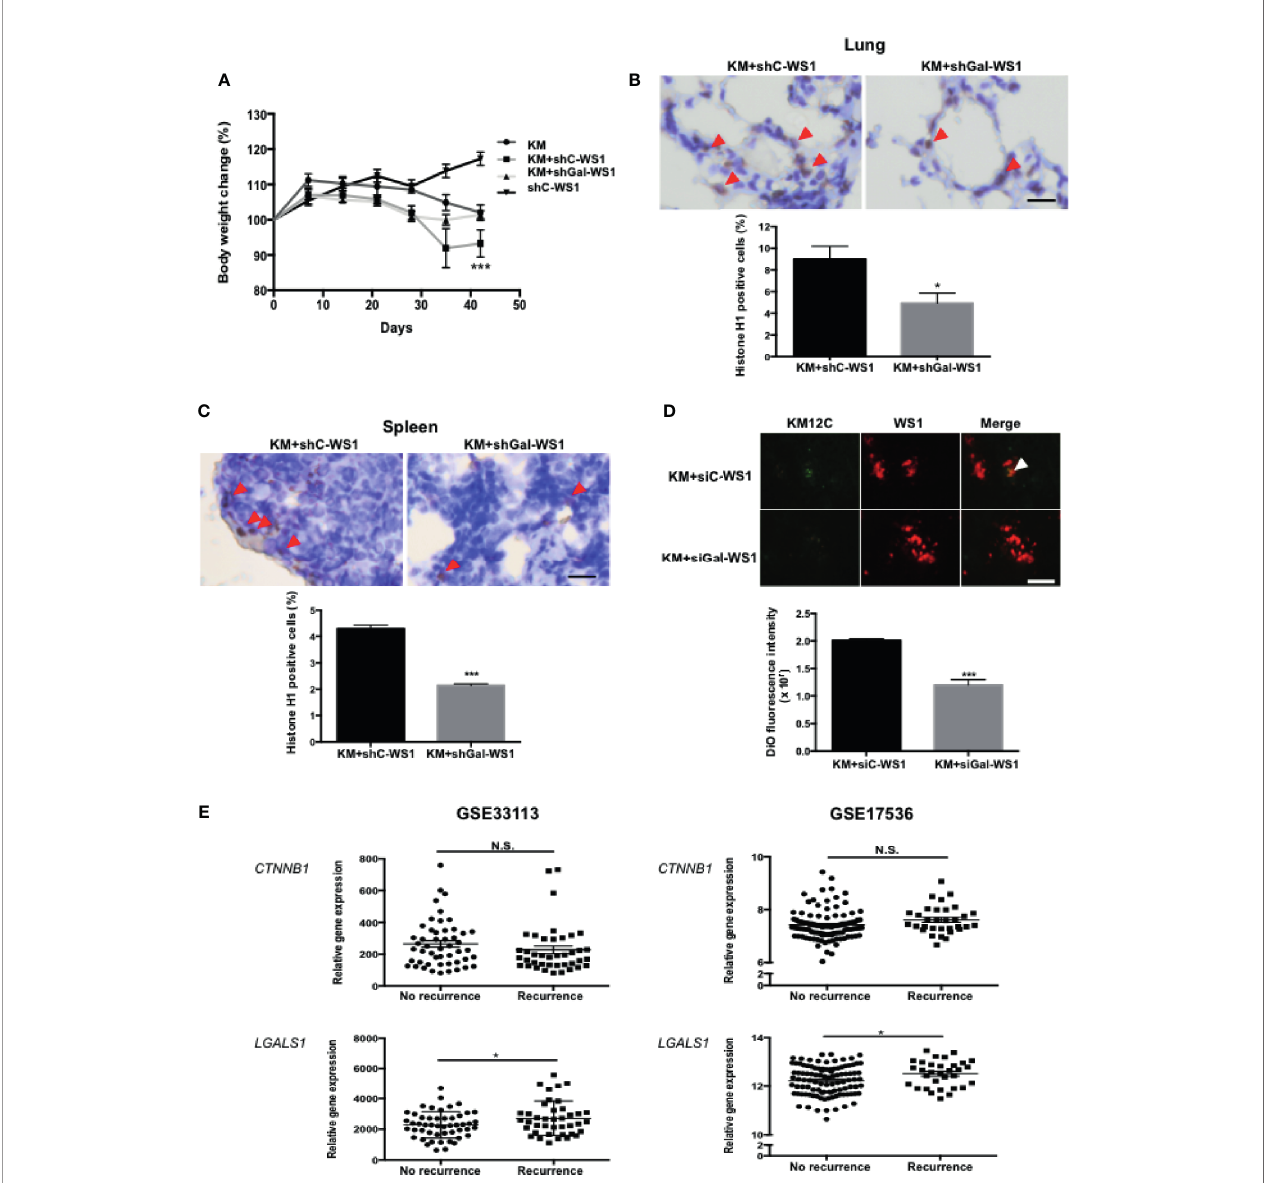
FIGURE 3 | Fibroblast-secreted Gal-1 signi fi cantly increases metastasis and tumor dissemination of CRC cells in vivo . (A) Body weight of NOD-SCID mice 40 days after tail vein injection of KM12C only (3 x 10 5 cells); KM12C (3 x 10 5 cells) admixed with WS1 silenced for with short-hairpin RNA (shRNA) of non-target sequences (shC-WS1; 3 x 10 5 cells); KM12C (3 x 10 5 cells) admixed with WS1 silenced with shRNA speci fi c for Gal-1 (shGal-WS1; 3 x 10 5 cells); or shC-WS1 only (3 x 10 5 cells). Each condition consisted of three mice, with their body weight measured every 7 days. Immunohistochemistry (IHC) staining for human histone H1 (brown nuclei) in (B) mouse lung and (C) spleen tissue sections; representative sections (top panel) and quantitative results (bottom panel) are shown, with arrows indicating human Histone H1(+) cells; scale bar, 20 m m. (D) Visualization of fl uorescently labeled co-cultured cells KM12C (3 x 10 5 cells; green fl uorescence, labeled with DiO), and siC- or siGal-WS1 (3 x 10 5 cells; red fl uorescence, labeled with with DiI) in lung sections 24 hours after injection into the tail vein of C57BL/6 mice. Top panel, representative images; bottom panel; quantitative results. Arrows indicate KM12C; scale bar, 100 m m. All results are shown as the mean ± SEM of three independent experiments. * p < 0.05, and *** p < 0.005 compared to the control. (E) Analyses of Gal-1 ( LGALS1 ) and b -catenin ( CTNNB1 ) expression with regard to disease recurrence in the public dataset GSE33113 and GSE17536 of gene expression omnibus (GEO); * p < 0.05; N.S., not signi fi